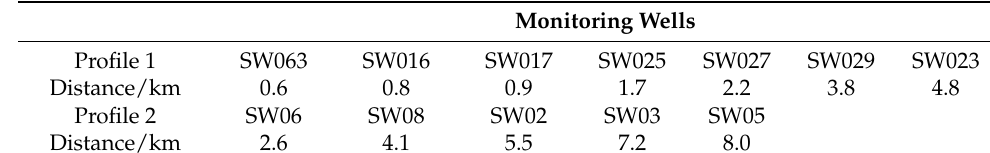
Table 2. Distance of monitoring wells from the Yangtze River.